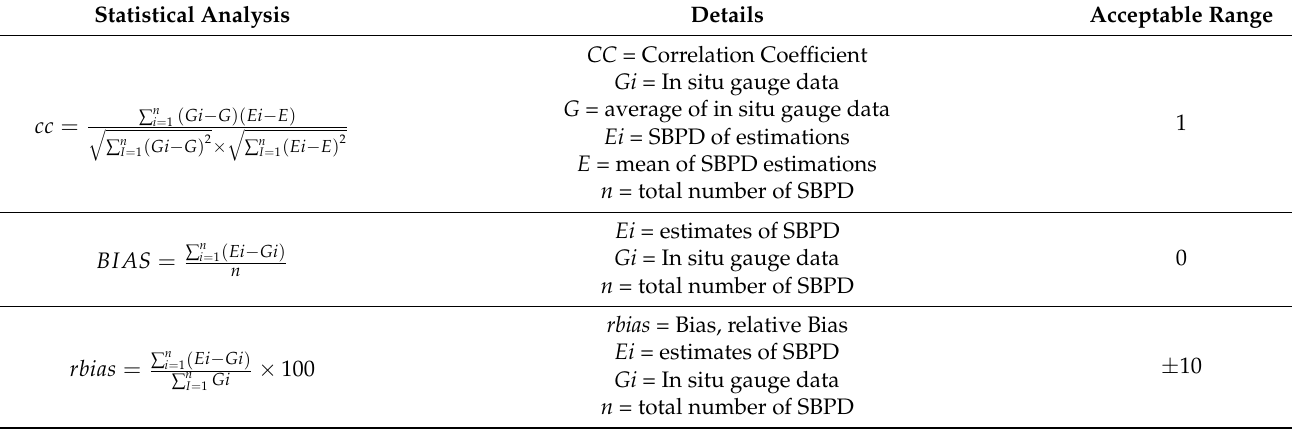
Table 3. The formulations of all evaluation and categorical indices used in performance